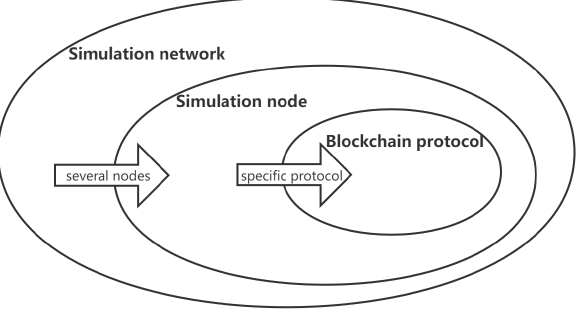
Figure 1. Logical relations among the components in the simulation